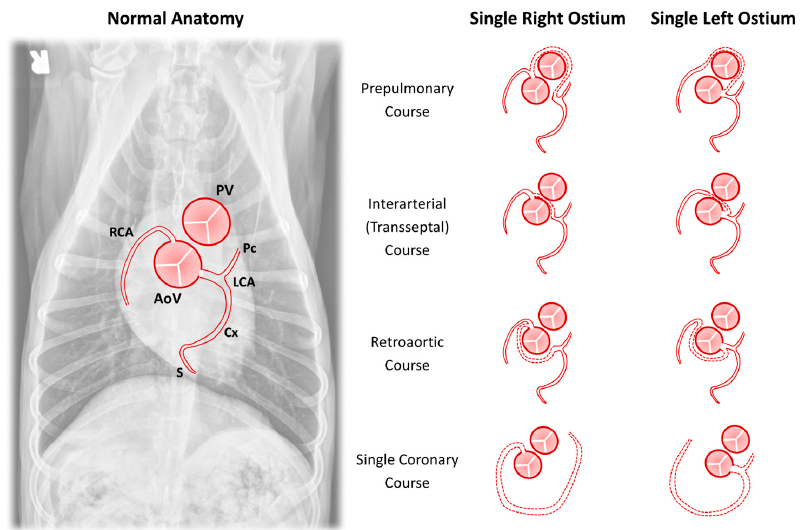
Figure 4. Schematic representation of anomalies of coronary arterial origin and course. The normal anatomy is shown superimposed on a ventrodorsal radiograph and this same orientation is maintained for each drawing. The drawings demonstrate variations in anomalous course (dashed lines) for the major coronary arterial branches in the setting of either a single right or single left coronary ostium. AoV = aortic valve; Cx = circumflex branch; LCA = left coronary artery; Pc = paraconal interventricular branch; PV = pulmonary valve; RCA = right coronary artery; and S = subsinuosal interventricular branch.